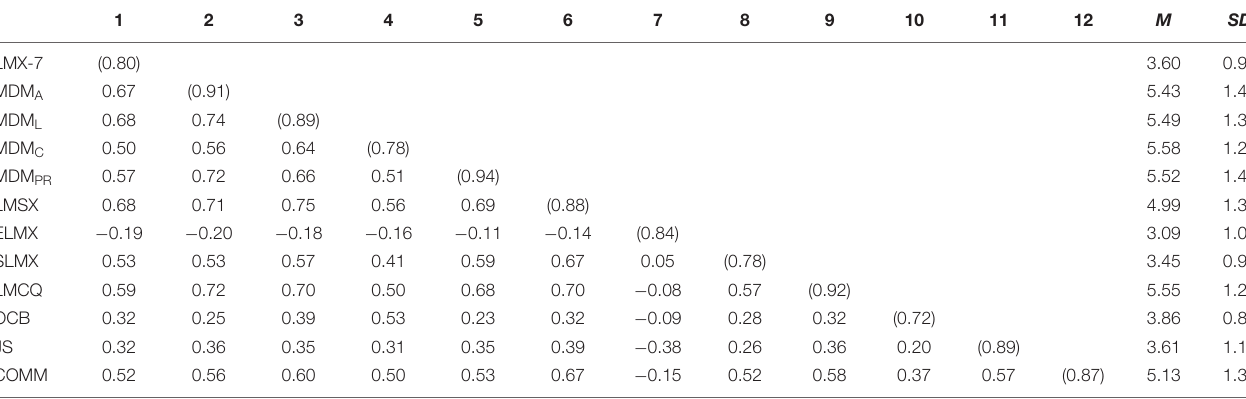
TABLE 3 | Correlations, alphas, means, and standard deviations (Study 1).